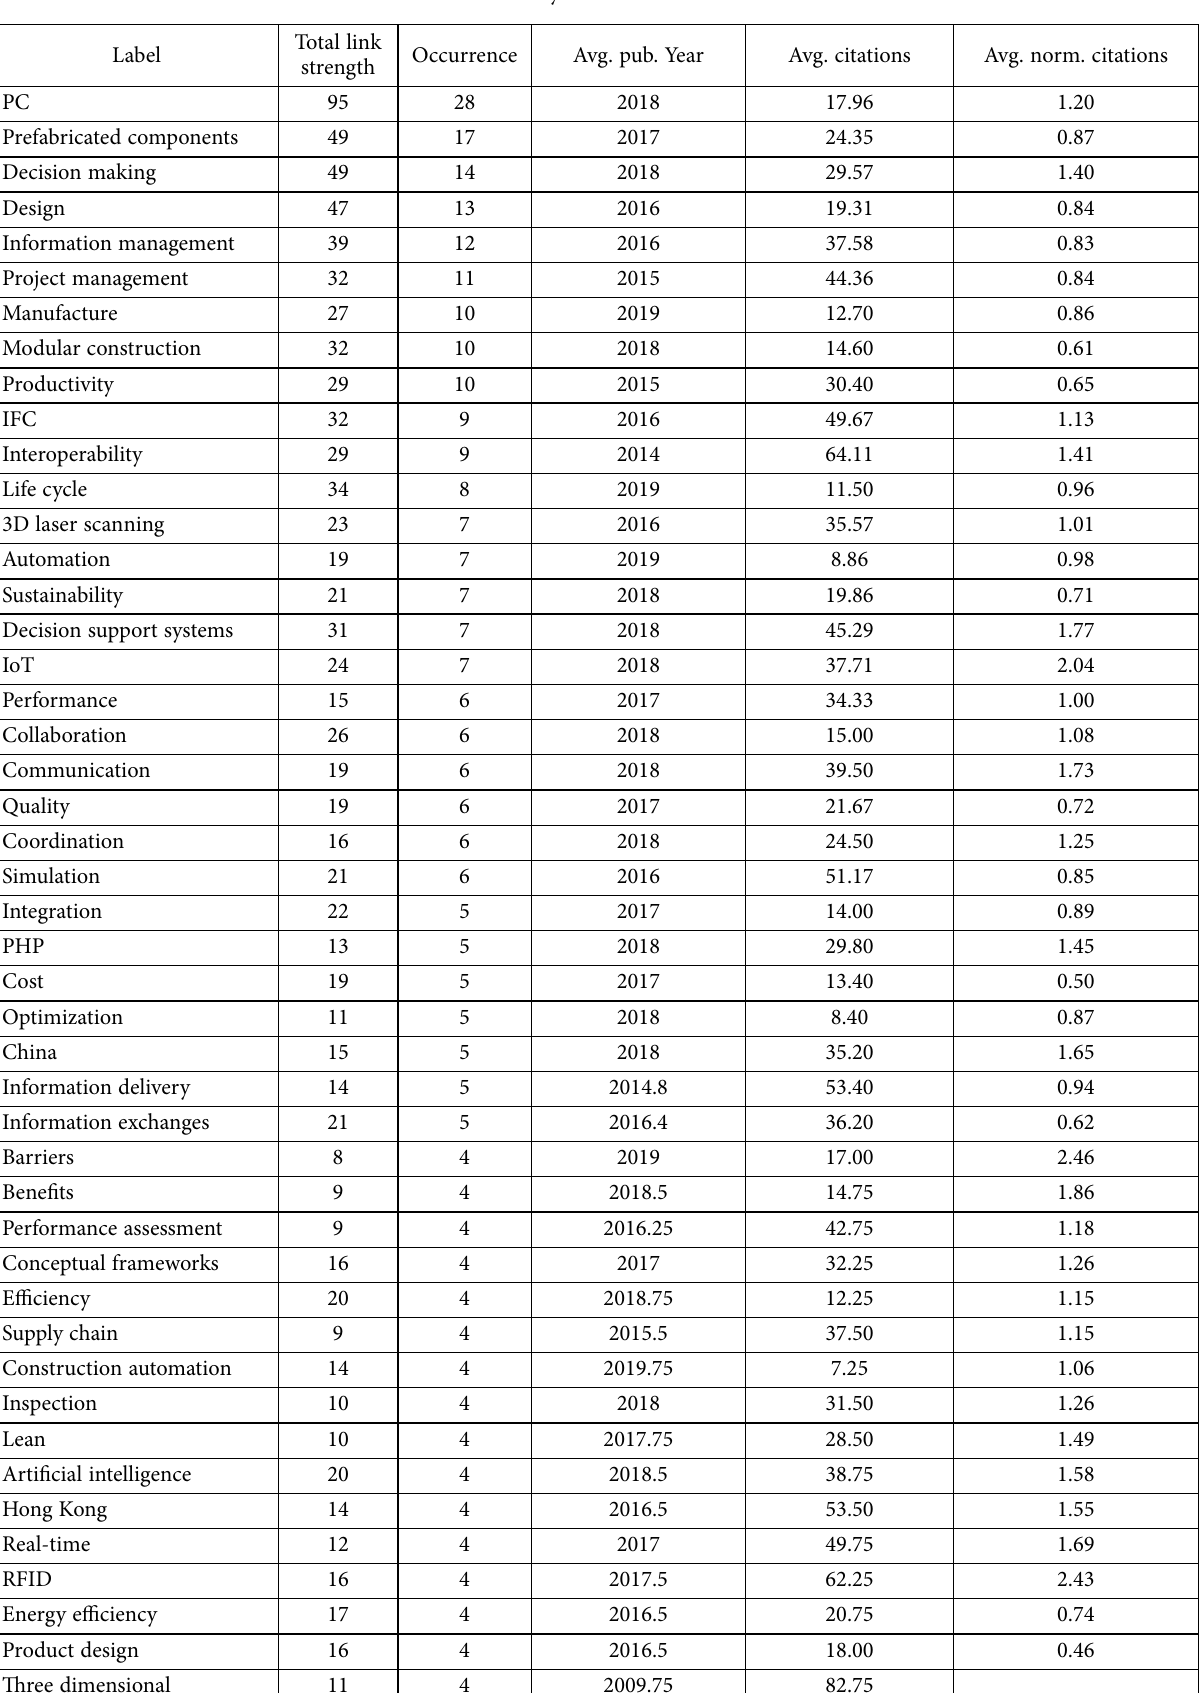
Table 4. Co-occurrence keywords in the articles of BIM for